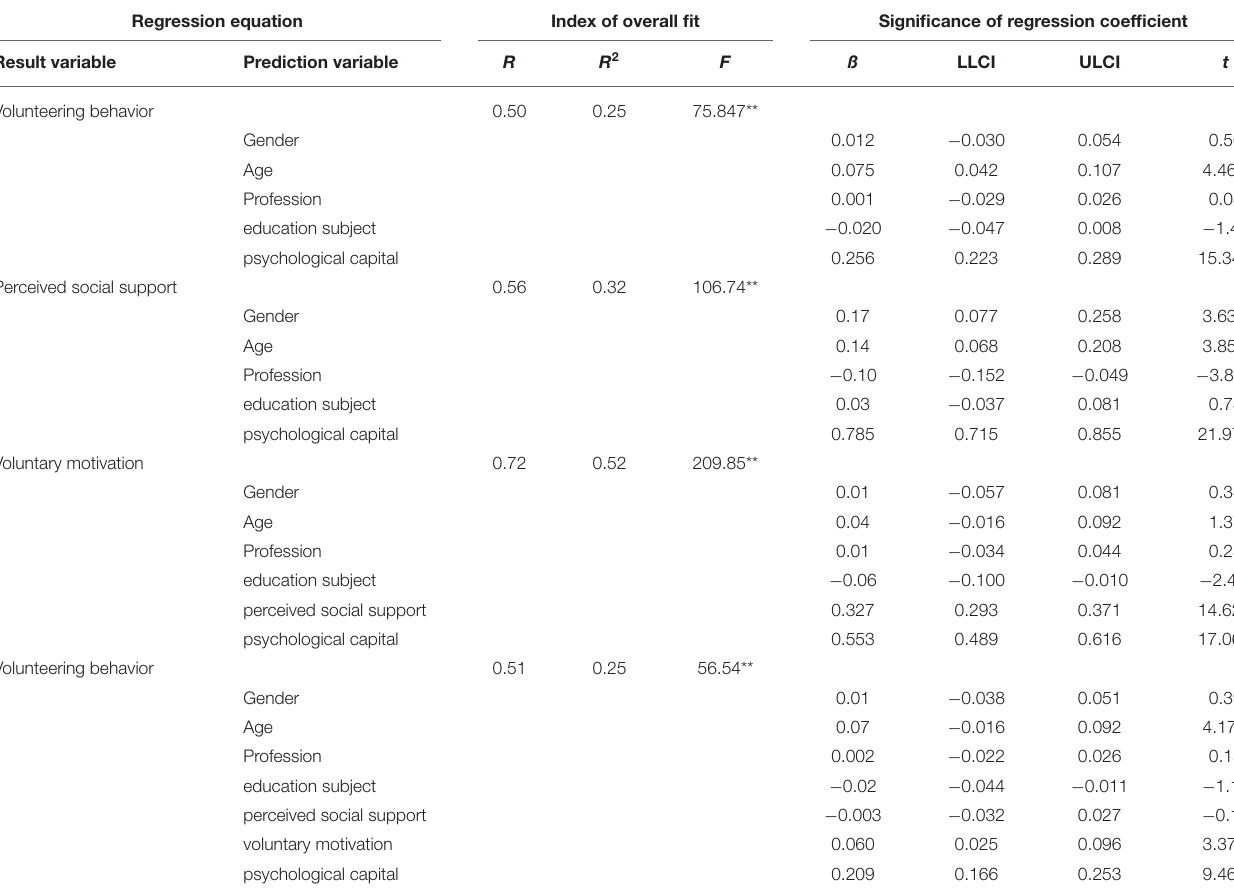
TABLE 2 | Analysis of chained mediation model.